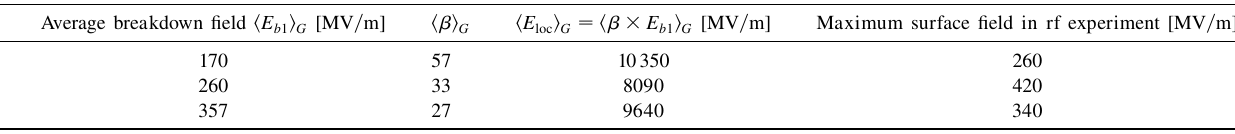
TABLE I. Average breakdown field ( h E i h (cid:1) (cid:3) E ) extracted from Gaussian fits to the histograms of all conditioning series. The last column gives the maximum surface b 1 G field from the rf experiment (Ref. [11]).